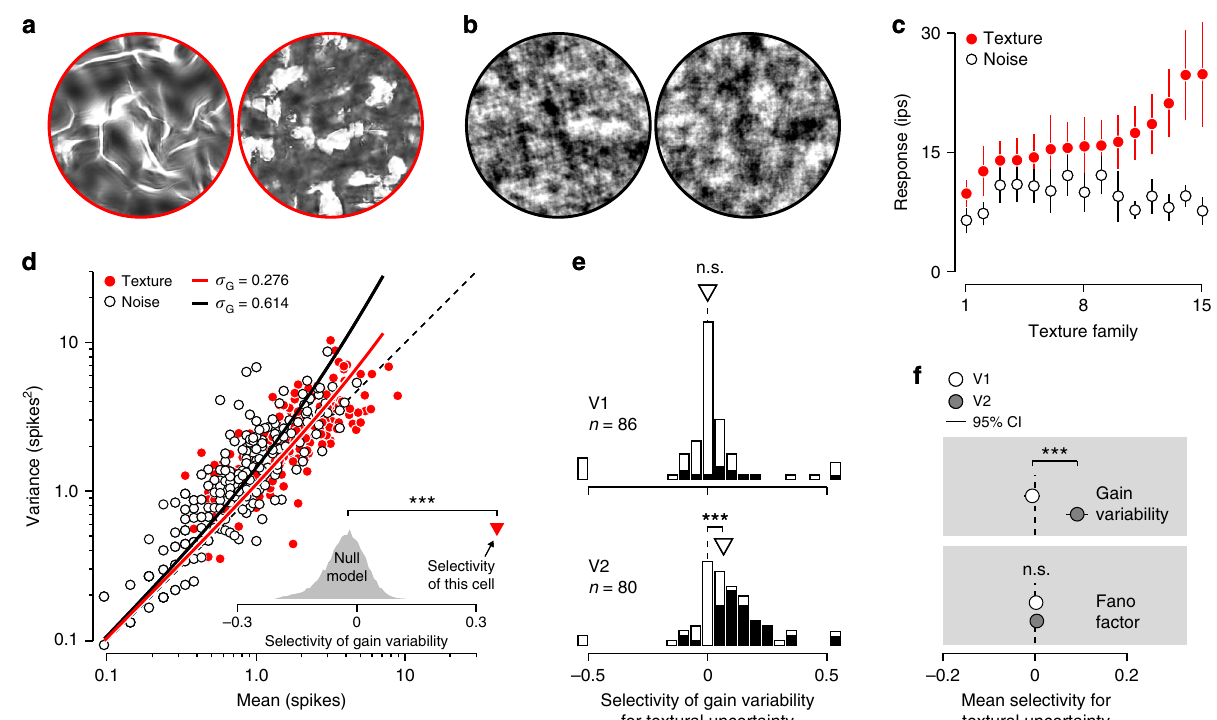
Fig. 4 Gain variability of V2 neurons represents texture uncertainty. a Two example images with well de fi ned textural properties (i.e. water, left; fl owers, right). b Noise images with ill-de fi ned textural properties. Perceptually, the texture images are more distinct than the noise images (C.M Ziemba, J. Freeman, E.P Simoncelli, J.A Movshon, Soc Neurosci. Abstr. 573.13, 2012). c This differential perceptual sensitivity is re fl ected in the stimulus selectivity of V2 neurons, but not of V1 neurons 21 . Mean response of an example V2 cell for 15 families of texture images (red points), and matched noise images (white points). Each family consisted of 15 unique images. Error bars indicate ± 1 s.e.m. d Variance-to-mean relation of the same cell for all unique texture and noise images (red vs white points, respectively). Lines illustrate the predictions of the modulated Poisson model, fi t separately to the texture and noise stimuli. The inset shows the selectivity of gain variability for textural uncertainty expected under the null model (gray histogram, see Online Methods), and the selectivity estimated from the real data (red triangle). e Distribution of selectivity of gain variability for textural uncertainty for a population of V1 (top) and V2 (bottom) neurons. The dotted line illustrates the median value of the null model. Filled bars represent cases that were signi fi cantly different from the null model (two-sided test, α = 0.05). The triangle indicates the median value. f Average selectivity for textural uncertainty computed for two measures of neuronal response variability. Error bars indicate ± 2 s.e.m; n.s. not signi fi cant; *** P < (Fig. 5c, full line; P = 0.17, two-sided absolute goodness-of- fi t test). Keeping this parameter constant, we predicted gain variability for the low-contrast stimulus conditions. The model correctly predicted the magnitude of the increase in gain variability (Fig. 5c, dashed line; P = 0.57). The uncertainty receptive fi eld could therefore be the functional consequence of a stochastic normalization computation.